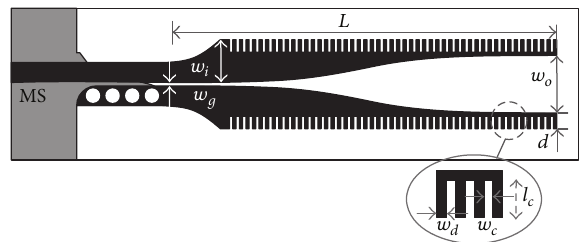
Figure 1: Microstrip-to-CPS balun: (a) layout and (b) simulated result. Balun dimensions (unit: mm): 𝑙 is 0.5 mm).